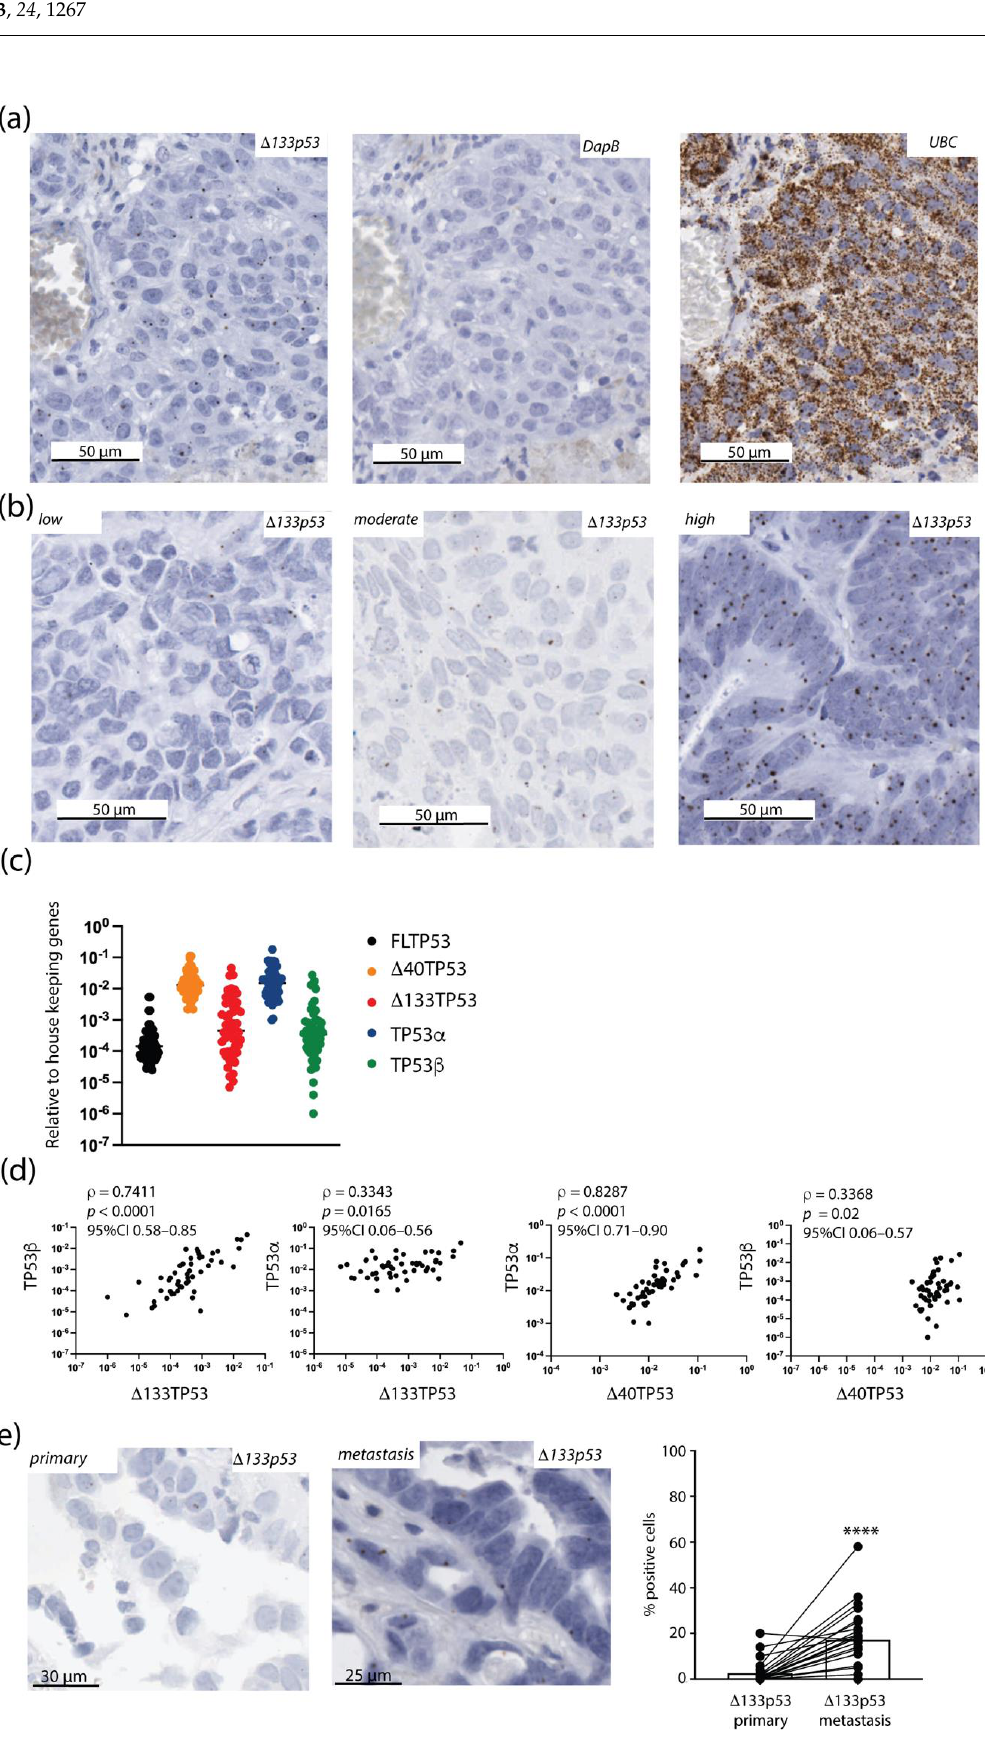
Figure 1. ∆ 133p53 β mRNA is present in tumors that metastasized to the brain. ( a ) ∆ 133p53 β mRNA expression in a brain metastasis using RNAscope alongside the UBC -positive and DapB -negative